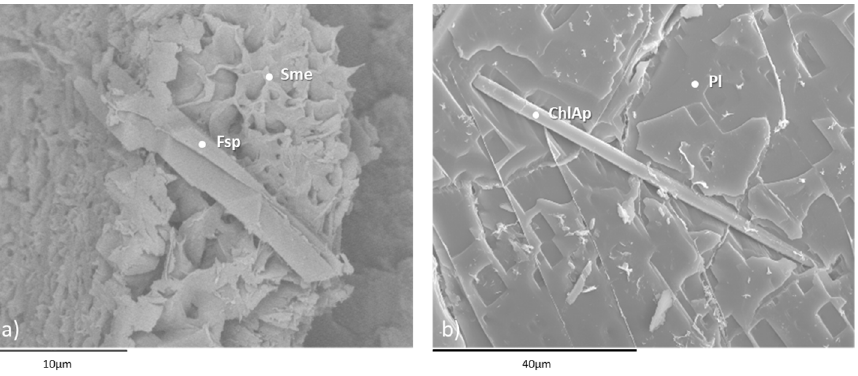
Figure 4. Microphotographs ( a , b ) obtained by scanning electron microscopy of backscattered elec- trons. Pl: plagioclase; Sme: smectite; ChlAp: chloroapatite; Fsp: feldspar.